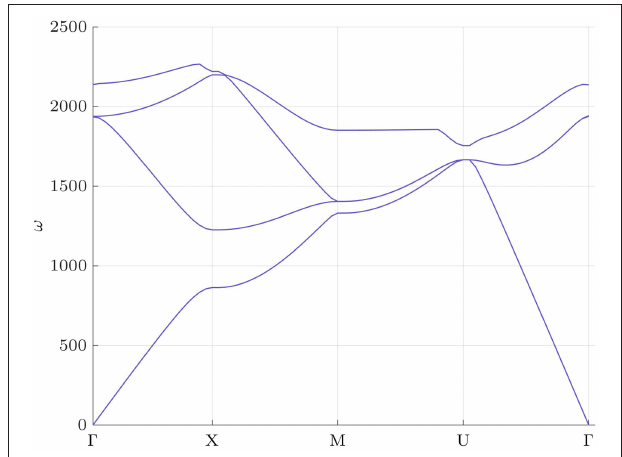
1 m) of = 0.4 m) representing the frequency ω (rad.s − 1 ) of = k ( m − 1 ), projection of the Bloch | |